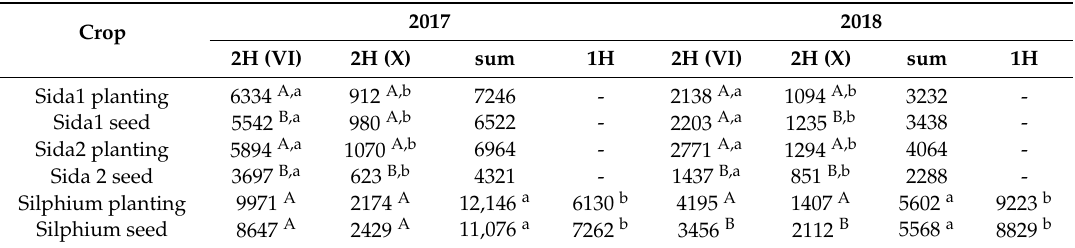
Table 4. Mean values of biogas yield per hectare (BY) of the analysed crops biomass, m 3 ha − 1 .